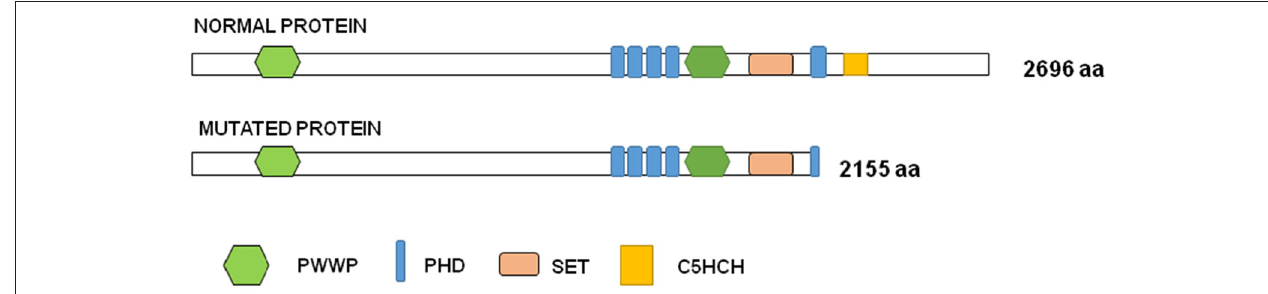
FIGURE 3 | Graph representation of NSD1 protein. Functional domains are represented in colors in the normal and in the mutated proteins: PWWP (proline-tryptophan-proline-tryptophan) is represented in green, PHD (plant homeodomain finger) in blue, SET (SU[VAR]3–9,E[Z], trithorax) in orange and C5HCH (Cys-His-rich domain) in